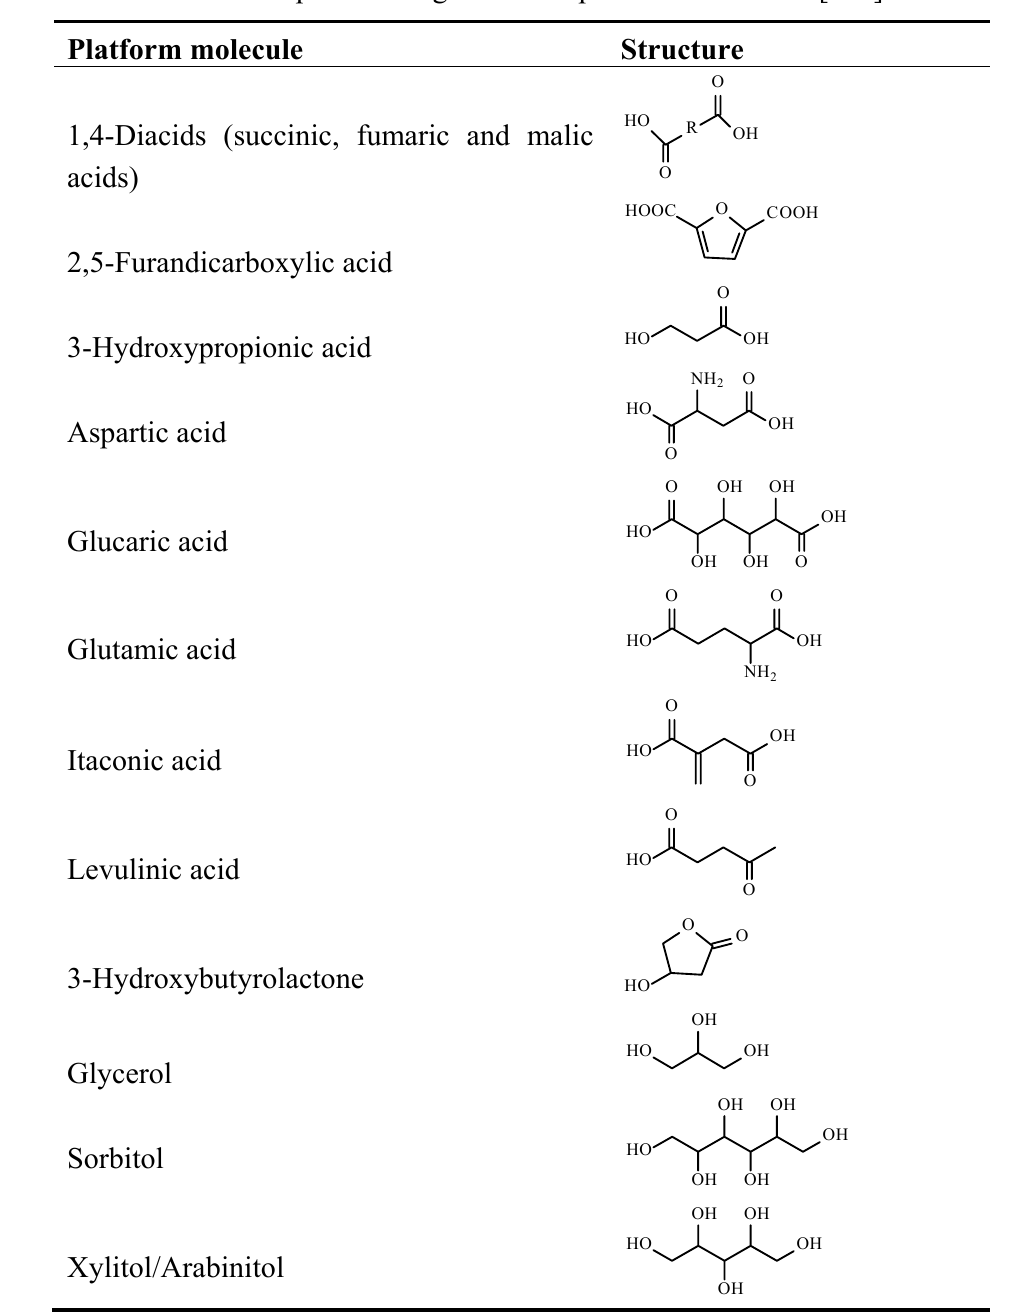
Table 2. Top twelve sugar-derived platform molecules